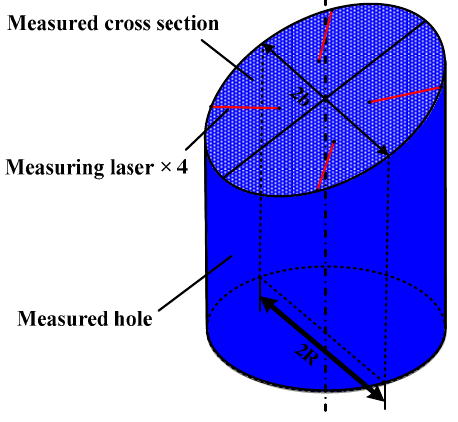
Figure 6. 3D measurement model.